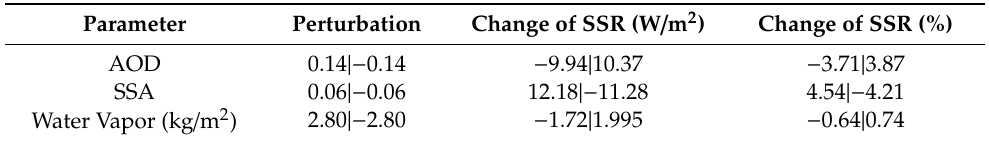
Table 2. Parameter perturbations used in radiative perturbation analysis and corresponding SSR changes.